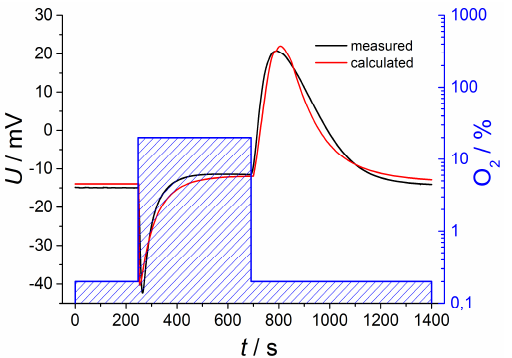
Figure 6. Calculated and measured voltages at two decades of oxygen